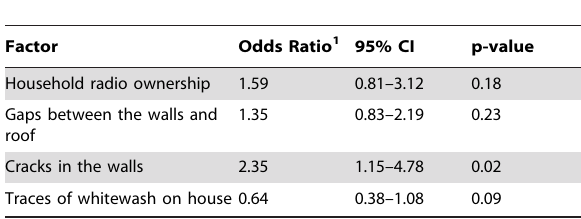
Table 4. Multivariable model of risk factors for T. cruzi infection among children 2–15 years